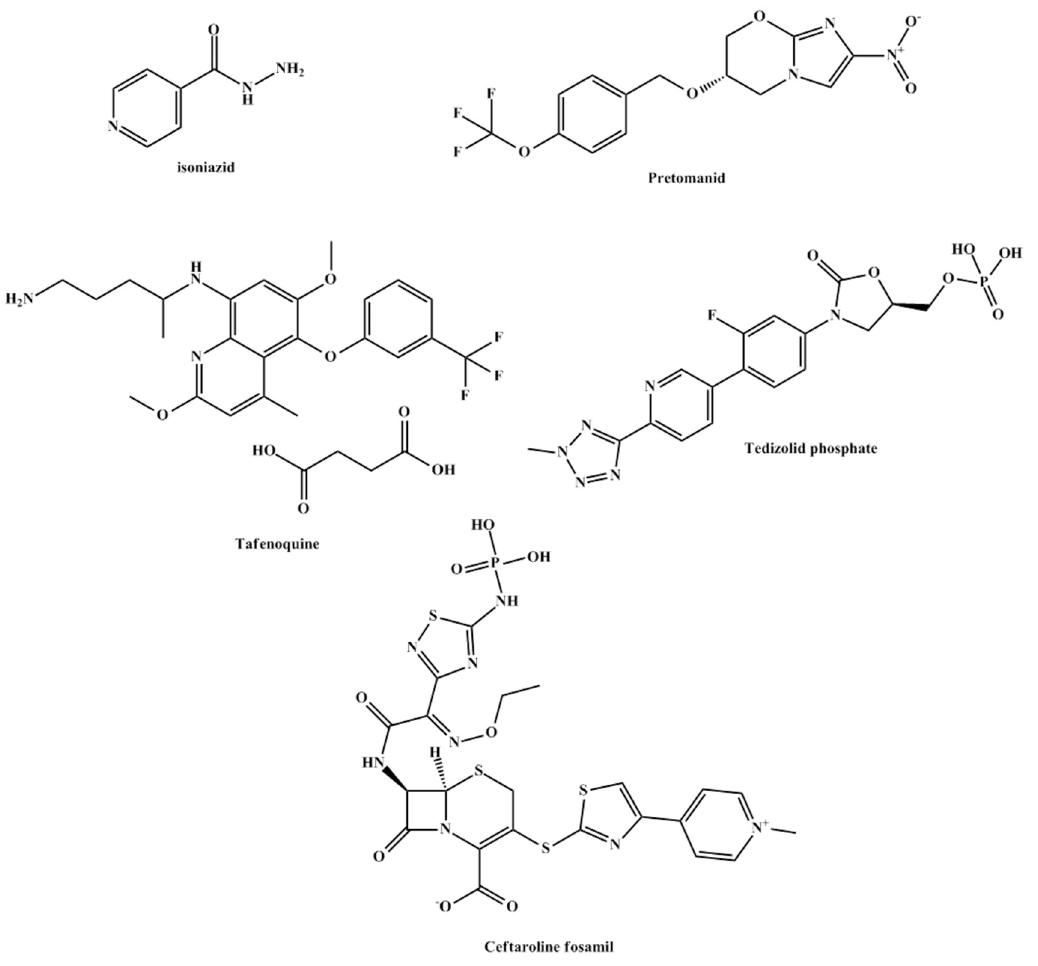
Figure 5. Structures of prodrugs reported in this sub-section.